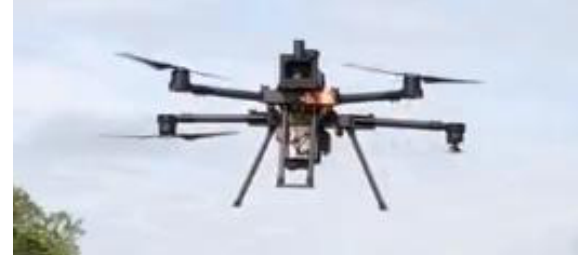
Figure 1. UX4 UAV and its payload